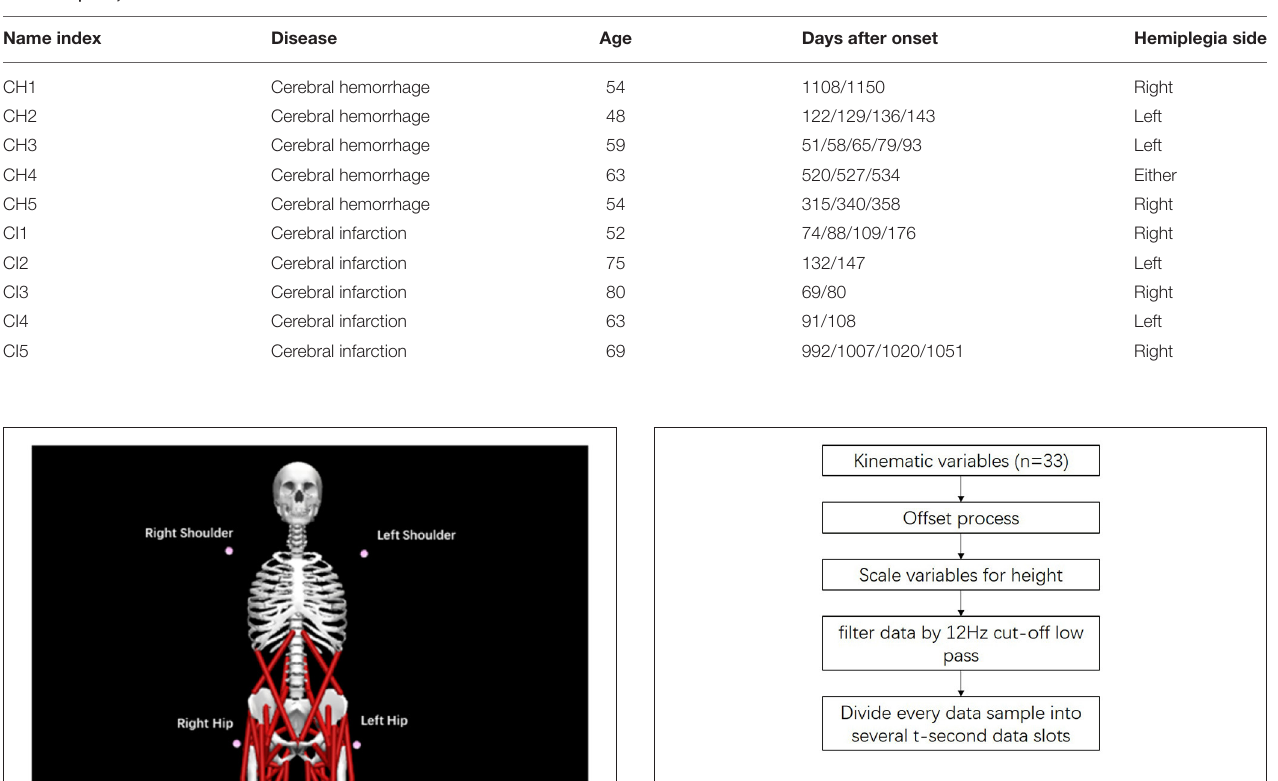
FIGURE 3 | Methodology framework of the feature extraction described in section